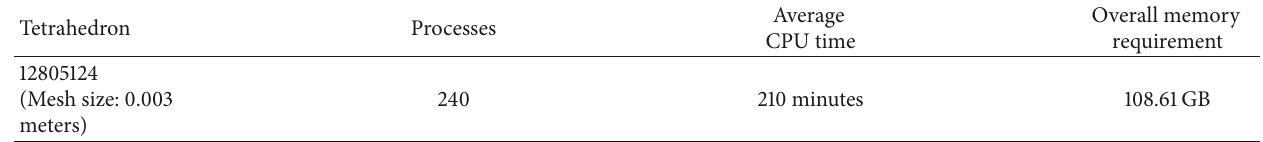
Table 2: Calculation statistics (the computing platform is the Xidian high performance computing